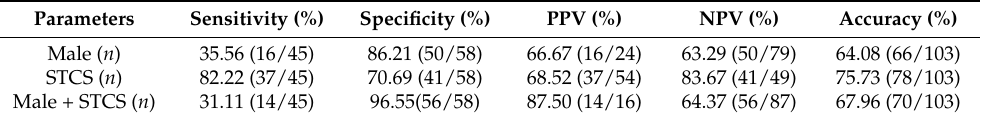
Table 2. Effectiveness of sex (male) or (and) STCS in predicting central lymph node metastasis in solitary solid PTMC with a taller-than-wide shape ( n = 103).